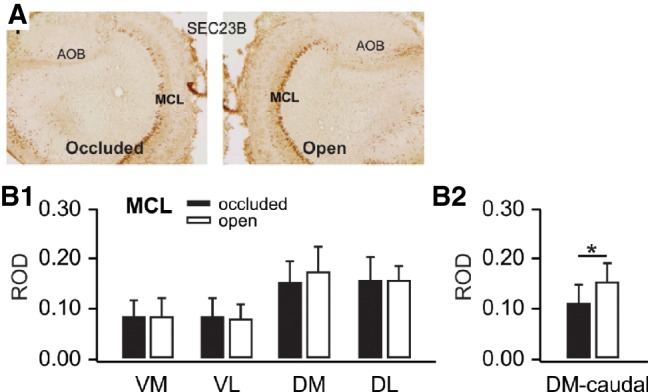
(A) Sec23b immunohistochemical staining in olfactory bulbs ipsilateral to occluded and open nares 50 min following odor + stroking training. (B1) Mitral cell layer ROD values for olfactory bulb quadrants receiving input from occluded and open nares. (B2) Dorsomedial mitral cell differences observed in the caudal samples for Sec23b. Error bars represent SEMs. * P < 0.05, see results for exact values.